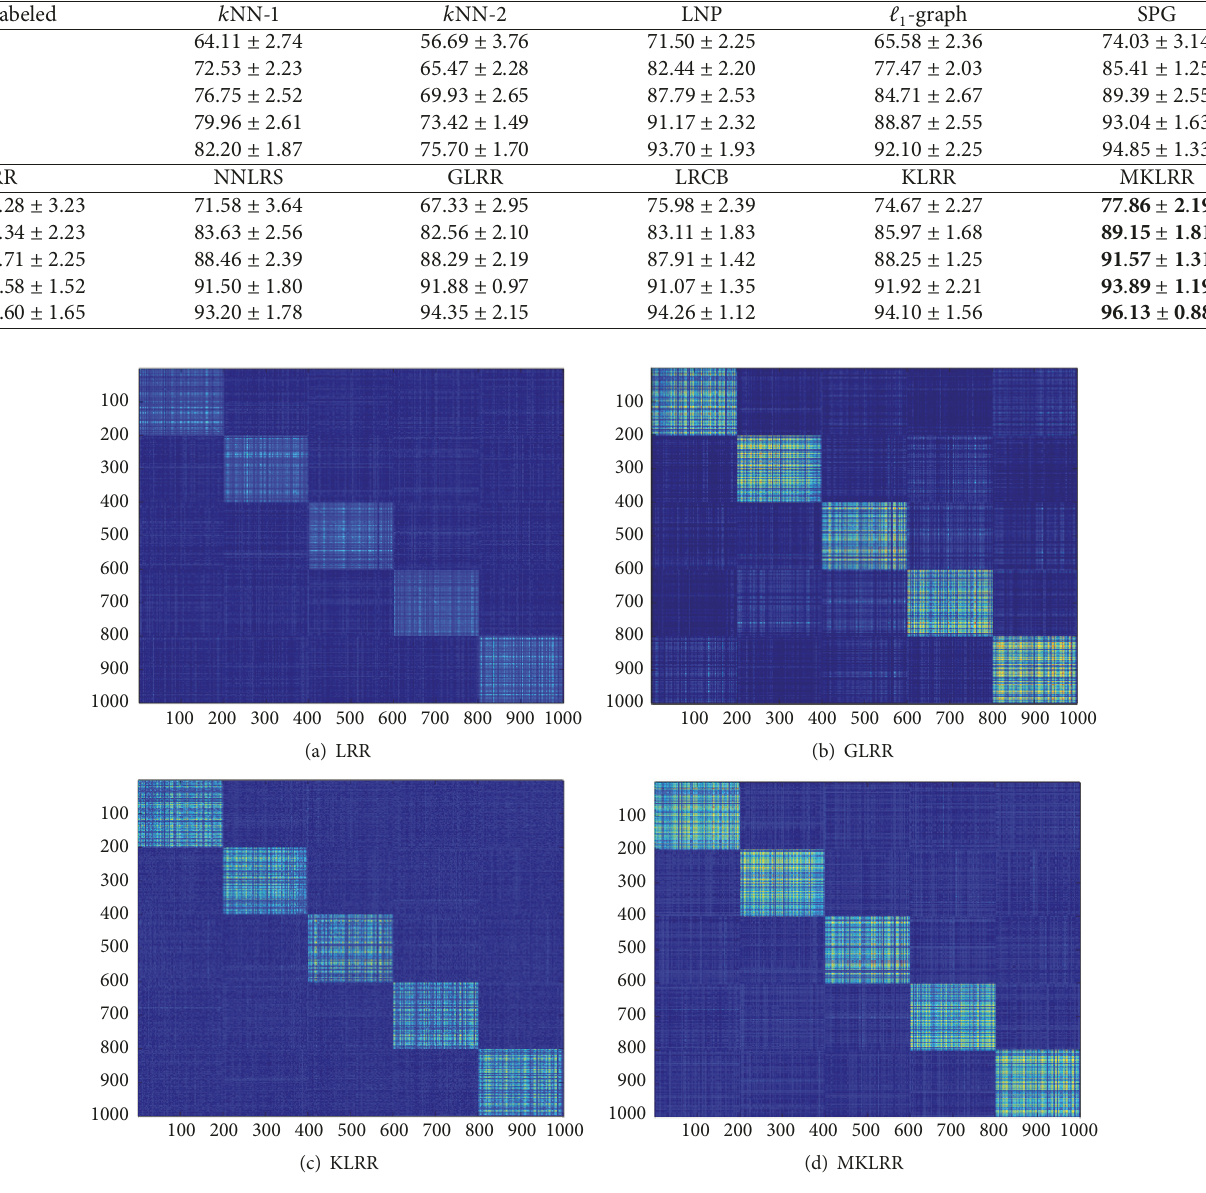
Figure 2: Block diagonal structures, respectively, learned by LRR, GLRR, KLRR, and MKLRR.